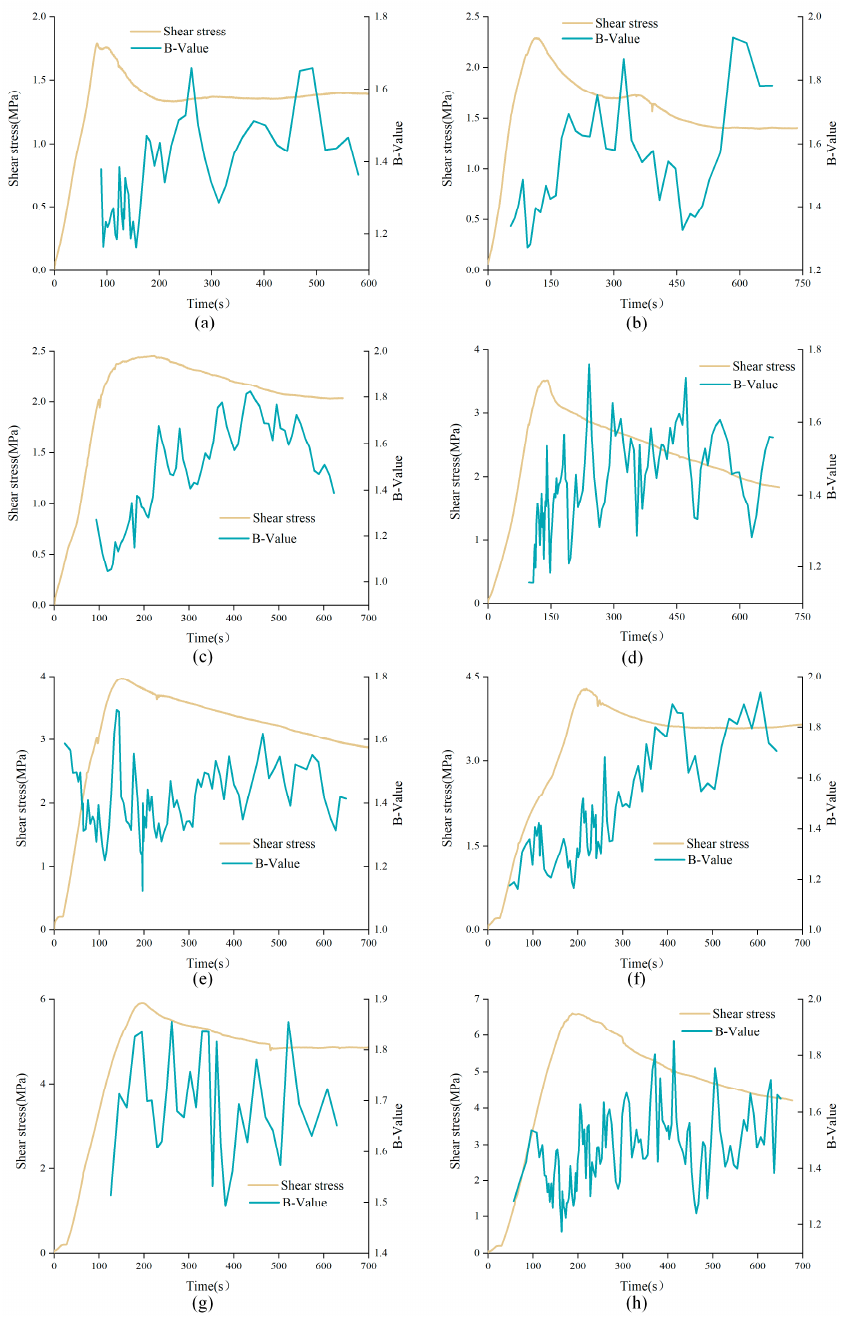
Figure 12. b -value curves of unanchored structural planes with different JRC under shearing: ( a ) DS-02-0-2, ( b ) DS-68-0-2, ( c ) DS-1214-0-2, ( d ) DS-1820-0-2, ( e ) DS-02-0-5, ( f ) DS-68-0-5, ( g ) DS-1214- 0-5, and ( h ) DS-1820-0-5 (specimen ID: DS-ab- α - σ , where DS represents direct shear experiment, ab represents the range of JRC, α means the anchorage angle, and σ means the normal stress).